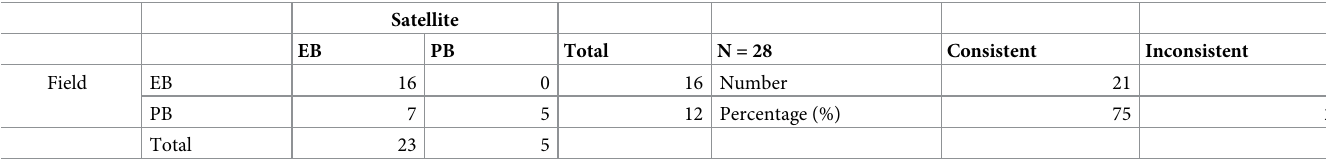
Error matrix (left panel) and accuracy results (right panel) of the developed field classification scheme against the remotely sensed classes of life stage at the time of cruise sampling using a pheophytin proportion of 28% for each field water column sample taken at 5 m depth. EB = Early Bloom, PB = Post Bloom. Note that only exact matches for station years with both satellite and field data available were